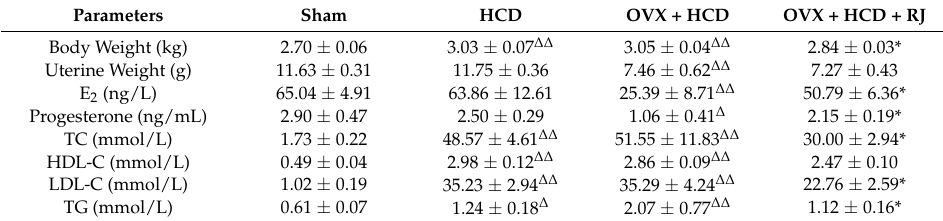
Table 1. Changes of body weight, uterine weight, and lipid metabolism in each group at 12 weeks.